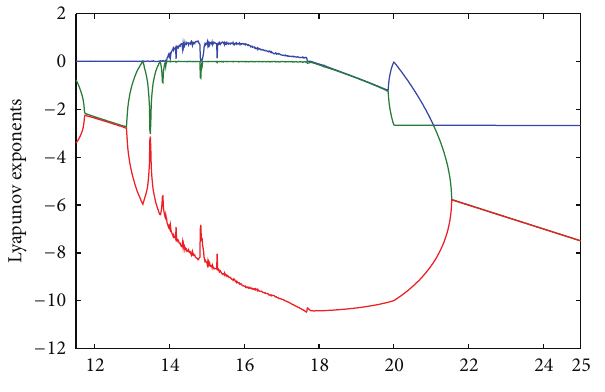
Figure 2: Lyapunov exponents spectrum of the system with respect to 𝑎 .